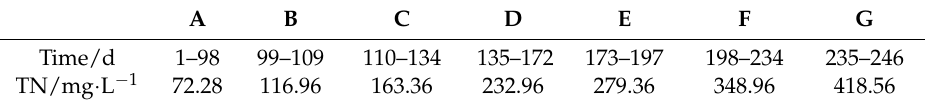
Figure 1. Total nitrogen (TN) concentration of effluent, TN removal efficiency, and stoichiometric ratios in an anaerobic sequencing batch reactor (ASBR) over the whole operation time. Table 2. Total nitrogen concentration of the ASBR at different stages (phase A to